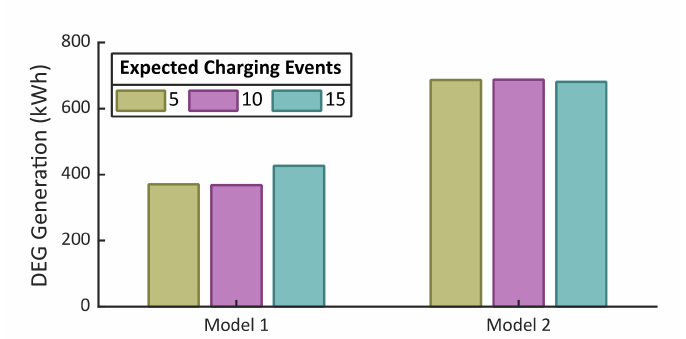
Figure 14. Total DEG generation in various scenarios.